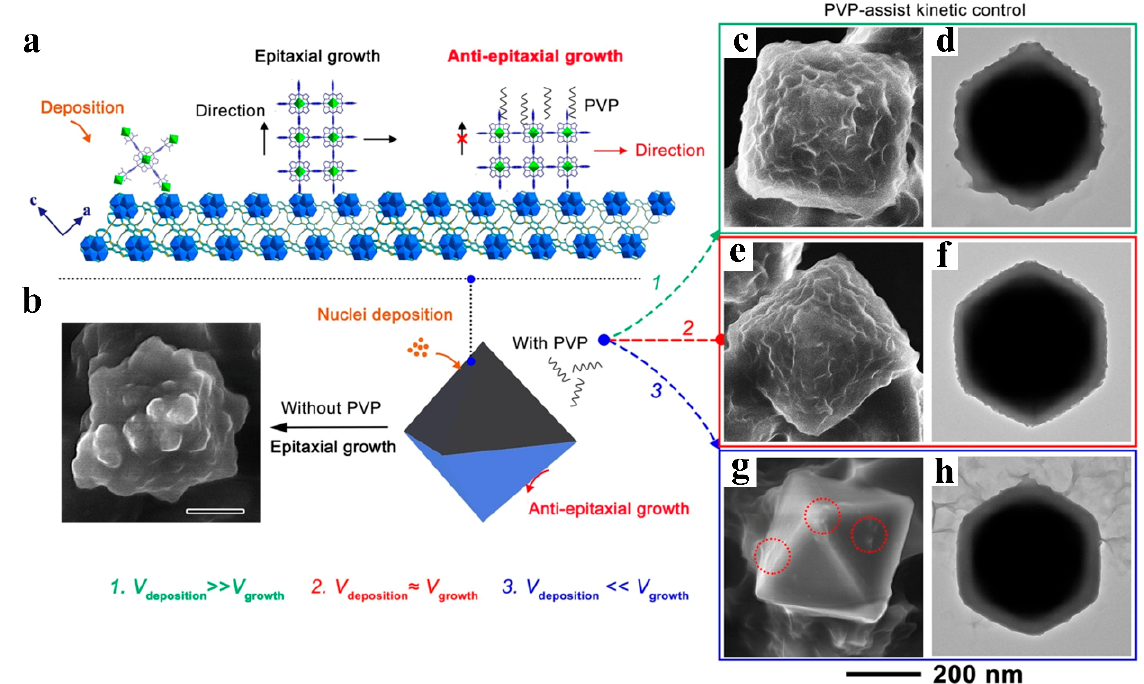
Figure 8. ( a ) The strategy exploration to form well-defined 2D-on-3D structures and to achieve the “anti-epitaxial growth” pattern of MOF nuclei. ( b ) The SEM image of the core satellite structure without the assistance of PVP. ( c – h ) display the SEM and TEM images when the system is in the presence of PVP and the relevant kinetic control results. ( c , d ) V deposition >> V growth , ( e , f ) V deposition ≈ V growth , ( g , h ) V deposition << V growth . Reproduced with permission from Ref. [71].